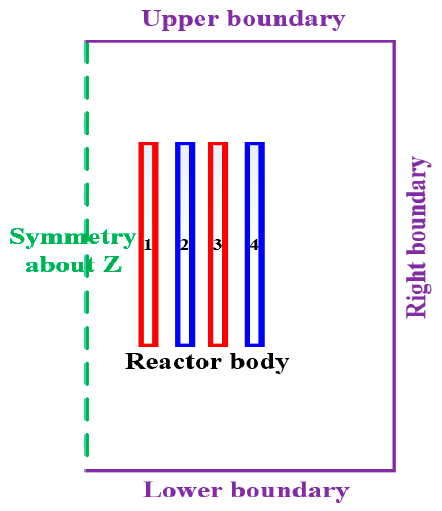
Figure 3. The equivalent model of the reactor body.